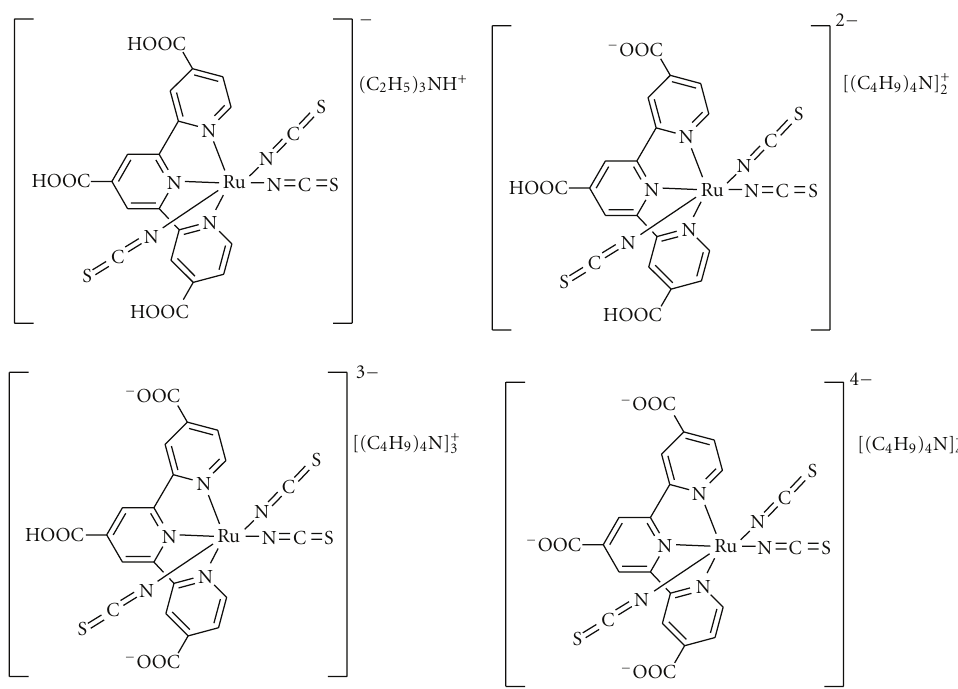
Figure 2: Molecular structures of ruthenium complexes (taken from [12]).